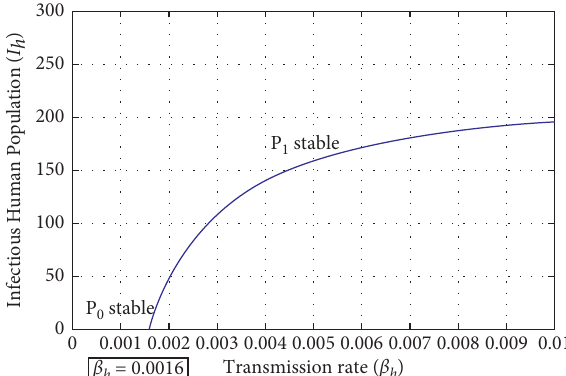
Figure 14: Bifurcation diagram without fumigation.